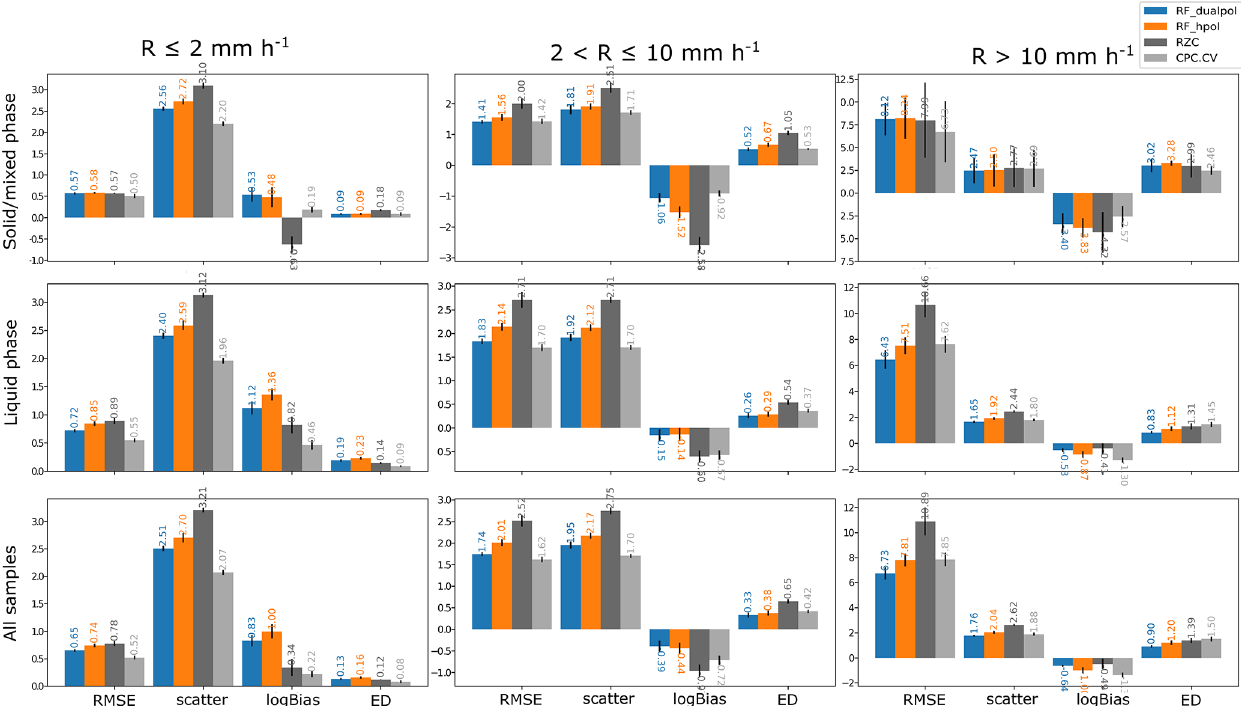
Figure C1. Five-fold cross-validation performance of RZC, CPC.CV, RF_dualpol and RF_hpol for different observed precipitation ranges for liquid and solid or mixed precipitation and for both together (which includes all additional observations from stations where no temperature measurement is available). The y scale is different for all precipitation ranges since the scores are significantly